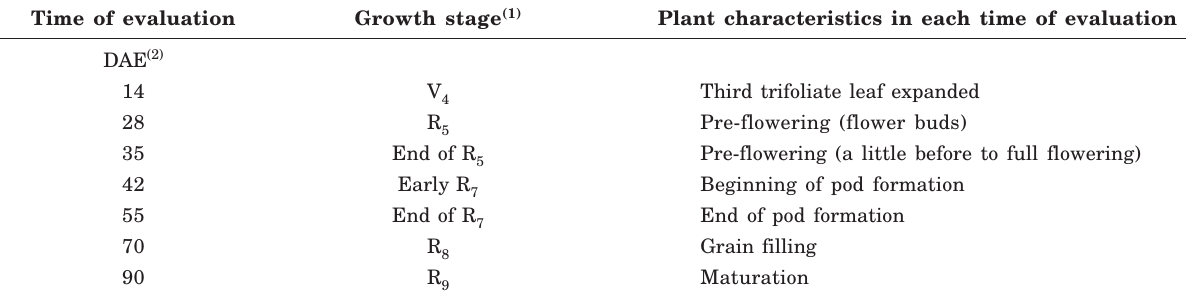
(1) Fernández et al. (1986). (2) Days after emergence. Table 2. Concentration of micronutrients (B, Cu, Fe, Mn and Zn) in leaf diagnosis, collected at R6 stage (37 DAE), of common bean cultivars under different levels of fertilization Treatment (1)